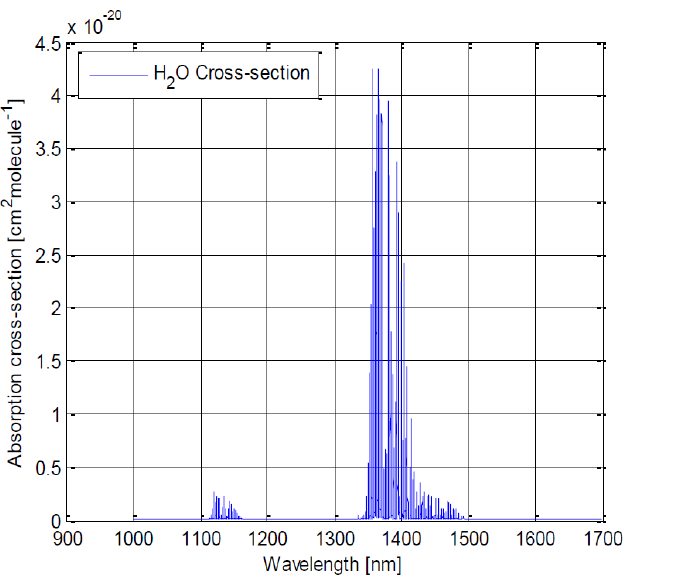
Figure 1. Absorption cross-section for H 2 O between 900 and 1700 nm. Key spectral lines are at 1130 and 1400 nm